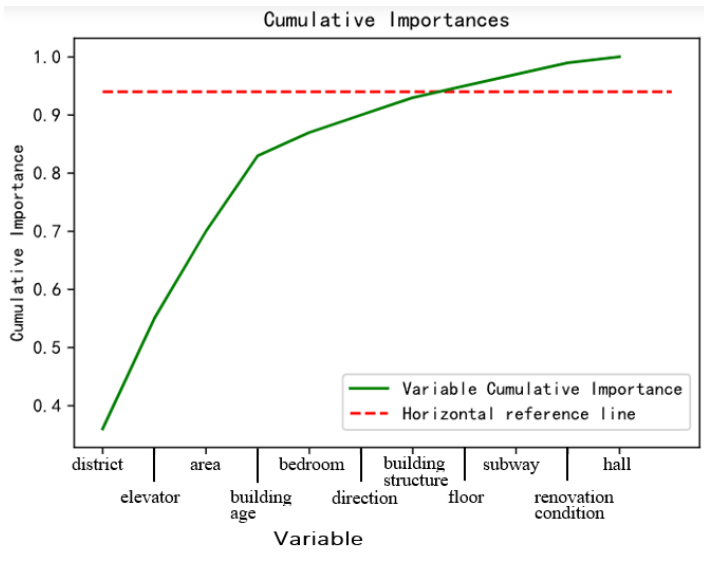
Fig. 15 The importance of each feature variable